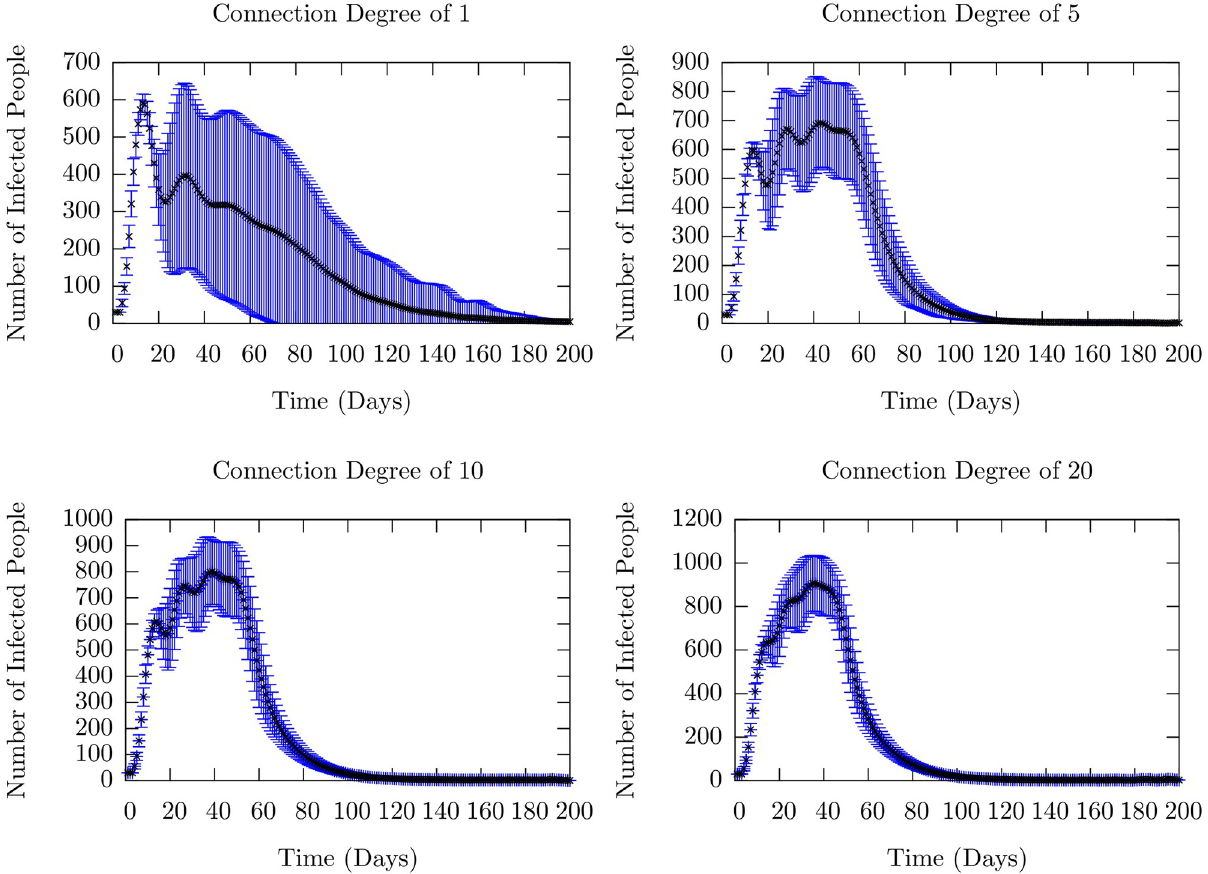
Fig 11. Mean number of infected (the sum of exposed and infectious) people as a function of time as the degree of inter-cohort connections is increased. The connection degree determines how many agents are connected to one of 25 randomly chosen agents in the preceding cohort. The black dots represent the ensemble mean, taken over 10,000 runs, while the blue lines represent the standard deviations. Individual runs which contributed to these averages are shown in S8 Fig. For a connection degree of 1, it is clear that a recurrence is present on average, as there are two peaks in the mean number which are clearly separated. As the number of connections drawn from an agent in the first cohort to the second are increased, we are increasing the strength of the coupling between the cohorts, as well as decreasing the average node-to-node distance between agents in different cohorts. Thus, as the connection degree is increased, we recover the single-cohort SIR-like infection curve in which there is one large period of